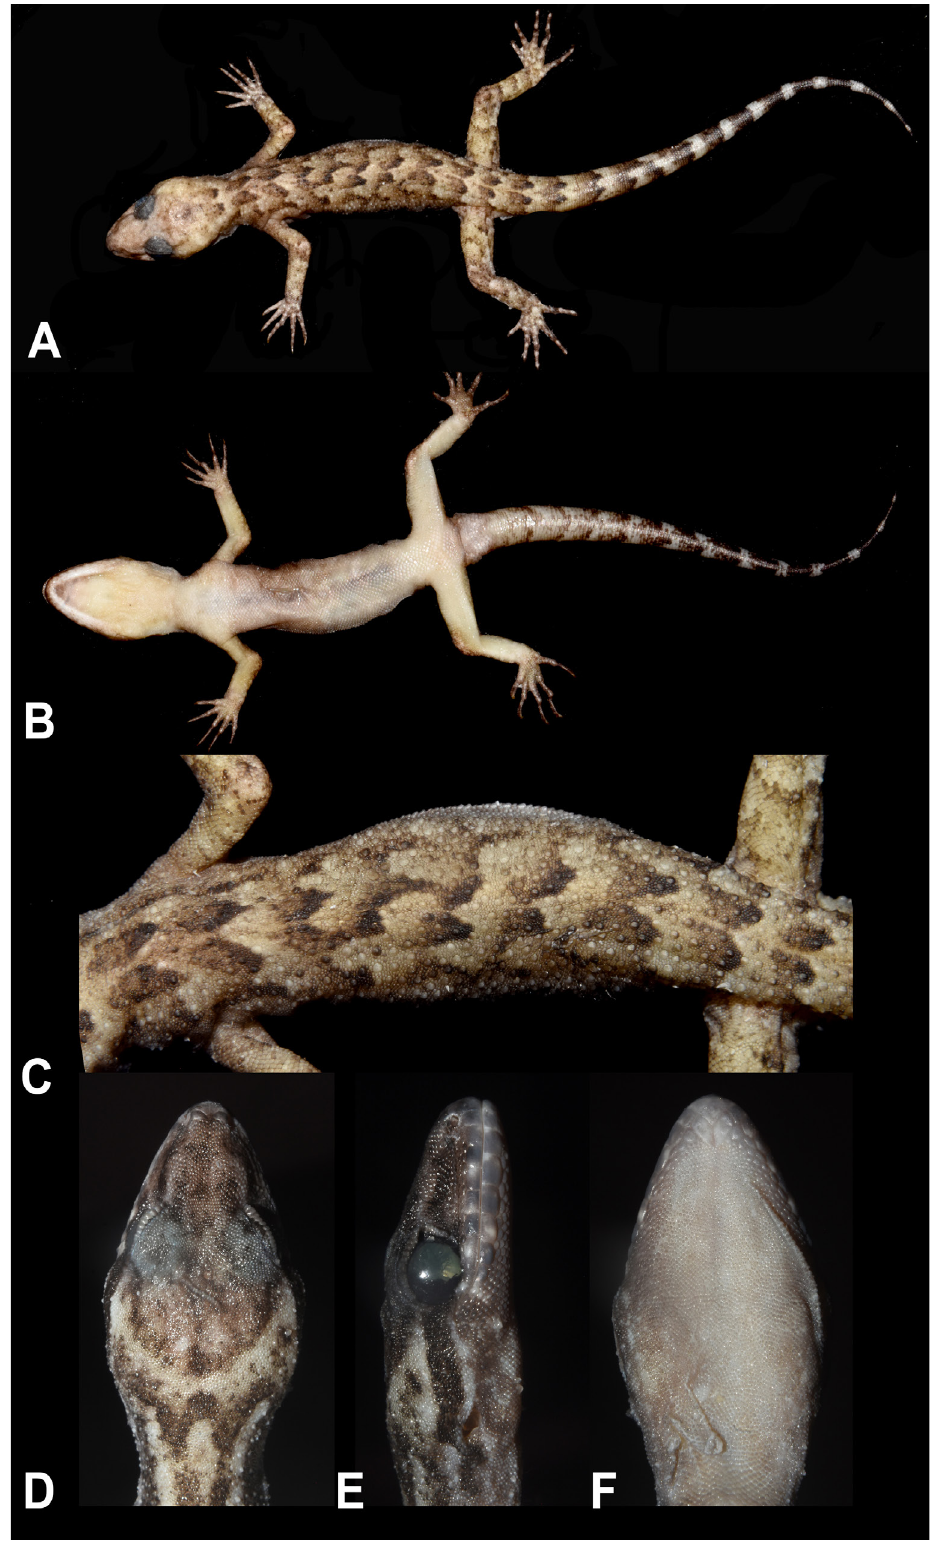
Fig. 4. Cyrtodactylus exercitus sp. nov., holotype (MZMU2542). A . Dorsal view. B .Ventral view. C . Details of dorsal pholidosis. D . Dorsal view of head. E . Lateral view of head. F . Ventral view of